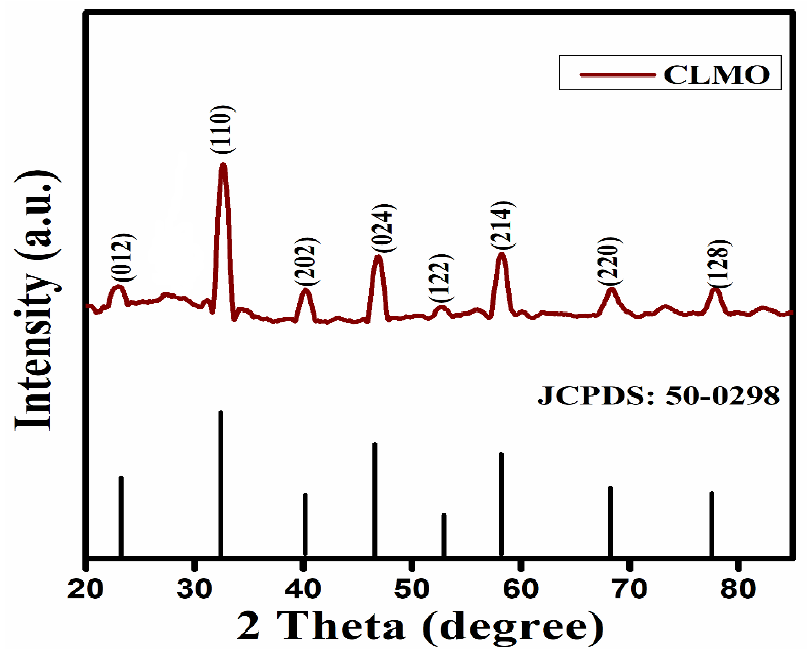
Figure 1. XRD patterns of the as-synthesized Ce 0.1 La 0.9 MnO 3 (CLMO) perovskite sample.